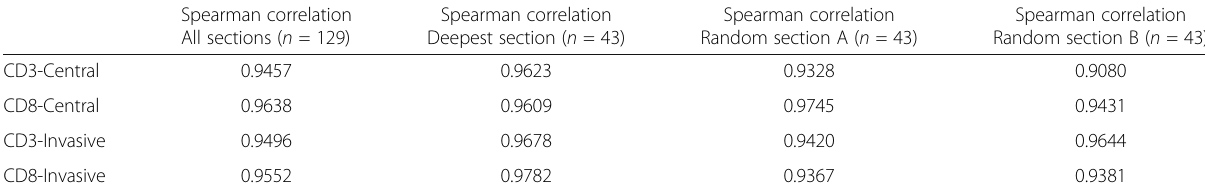
Correlation between numerical densities of CD3+ and CD8+ tumor infiltrating lymphocytes per mm 2 in central and invasive tumor areas, respectively, estimated by either stereology or image analysis for all tumor sections and for individual tumor sections. Spearman ’ s correlation, p <